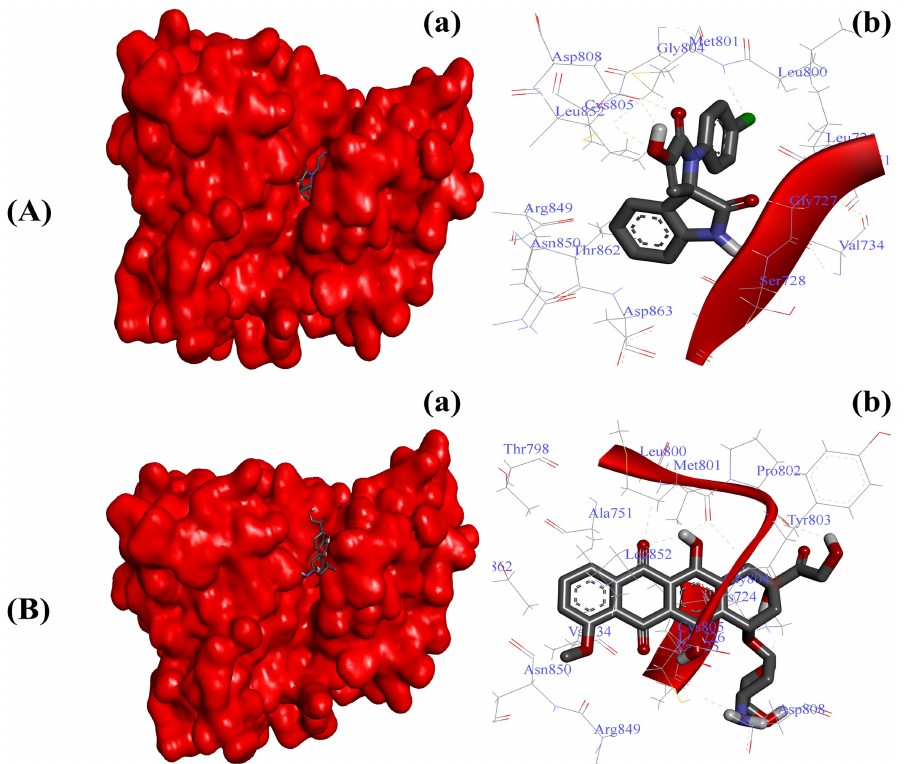
Figure 5. Substituted SOX ( 4a ) occupies the binding pocket of HER-2 (PDB ID: 3PP0). ( A ) Binding pattern of the substituted SOX ( 4a ) against human AKR1D1 ( ∆ G: − 7.27 Kcal/mol); ( B ) Binding pattern of doxorubicin against human CD44 ( ∆ G: − 8.94 Kcal/mol). Subpanels ( a ) represent the interaction of 4a and doxorubicin inside the active pocket of the target protein (represented as a red surface). Subpanels ( b ) show the 2D image of the interacting residues of the HER-2 with our